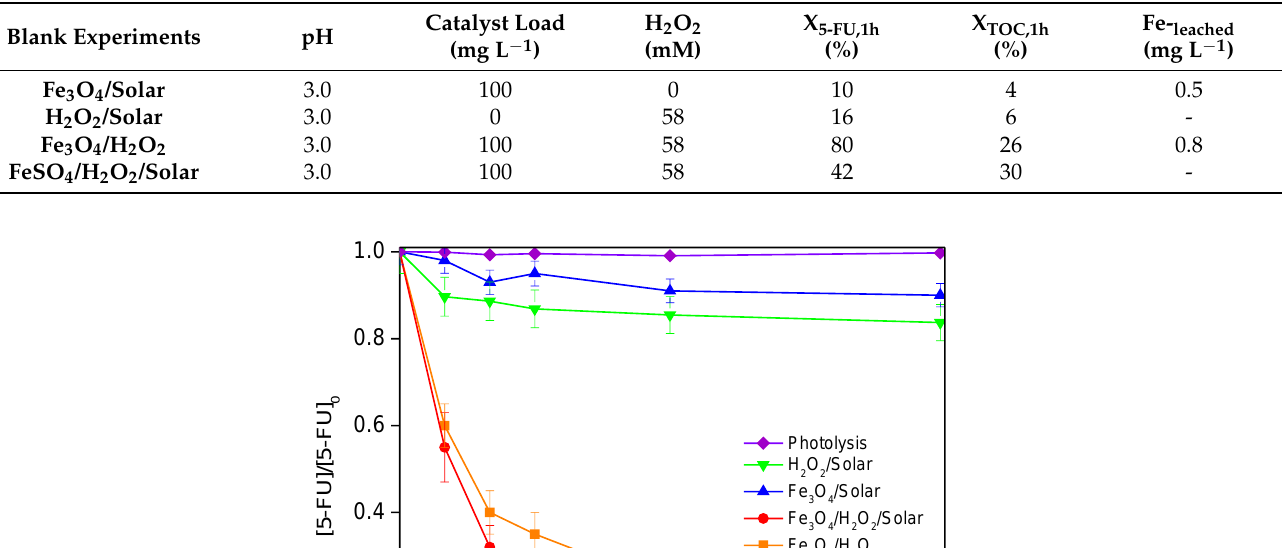
Table 2. 5-FU conversion (X 5-FU,1h ), total organic carbon conversion (X TOC,1h ), and iron-leached (Fe- leached ) for the blank experiments.